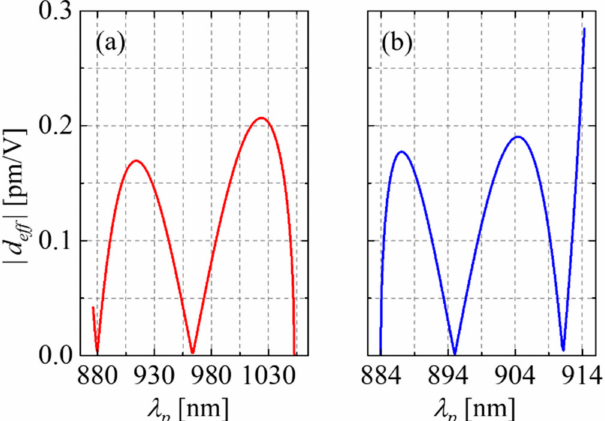
Figure 4. E ff ective nonlinear optic coe ffi cients ( d e ff ) for ( a ) Type I and ( b ) Type II calculated numerically under the EPM conditions.